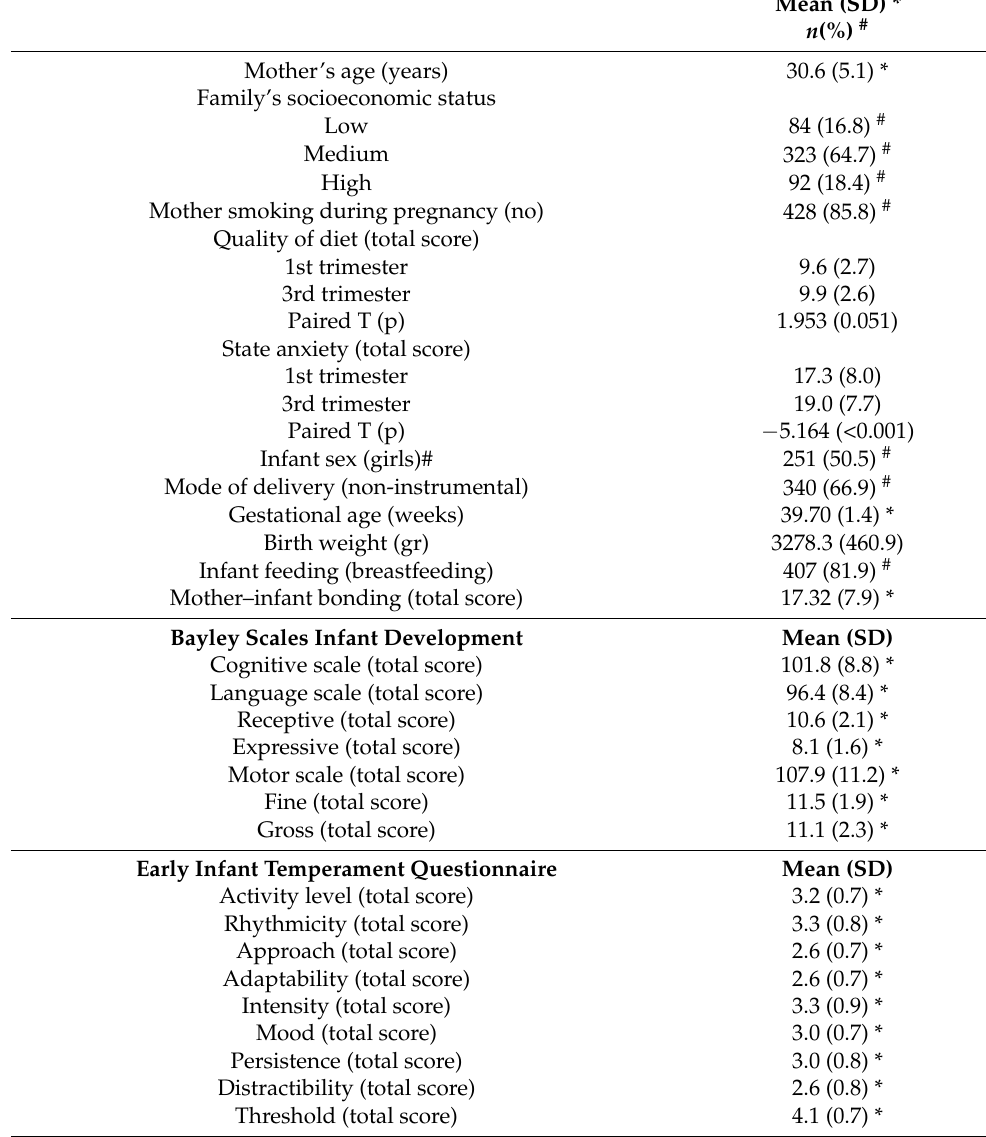
Table 2. Sociodemographic and perinatal descriptive variables.